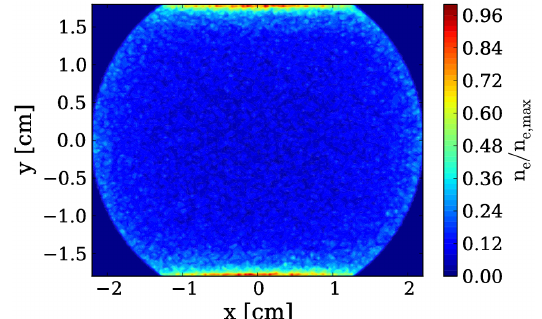
bunch in a field-free region. The LHC pipe geometry is used. Bunch population is 10 11 .